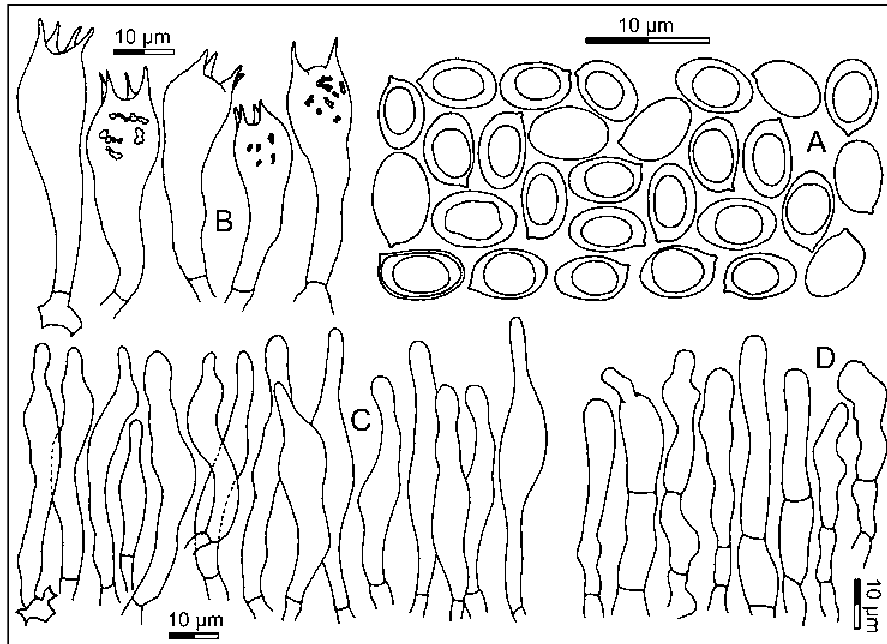
Fig. 2. Spores (a), basidia (B), cystidia (C) and caulocystidia (D) of Chalciporus rubinus re- corded in Wrocław (12.06.2007, coll. by J. Szypuła; drawn by M.